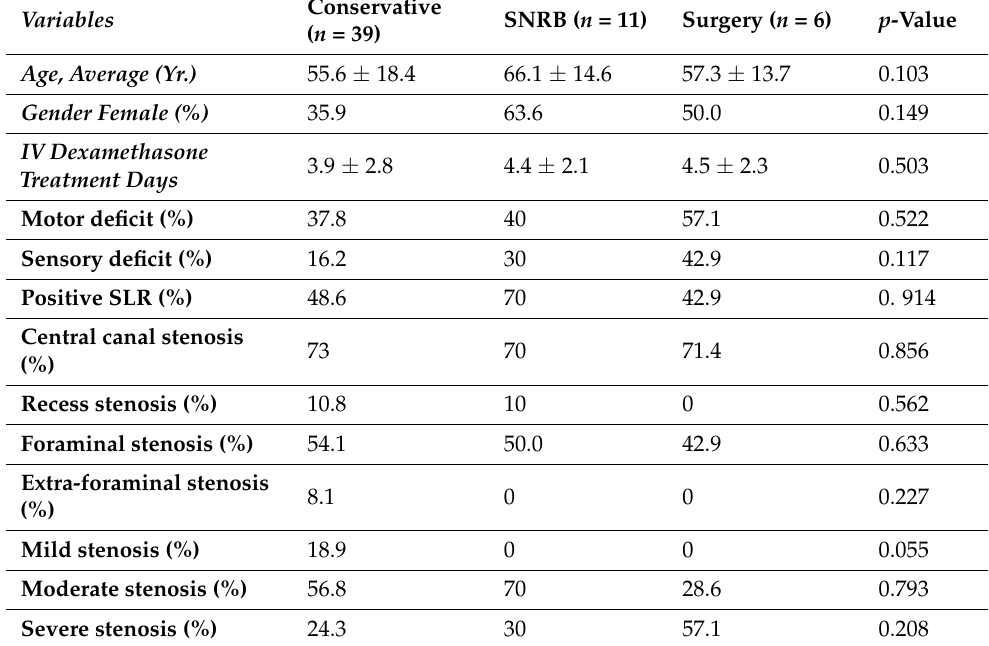
Table 1. Cohort Demographics (N =